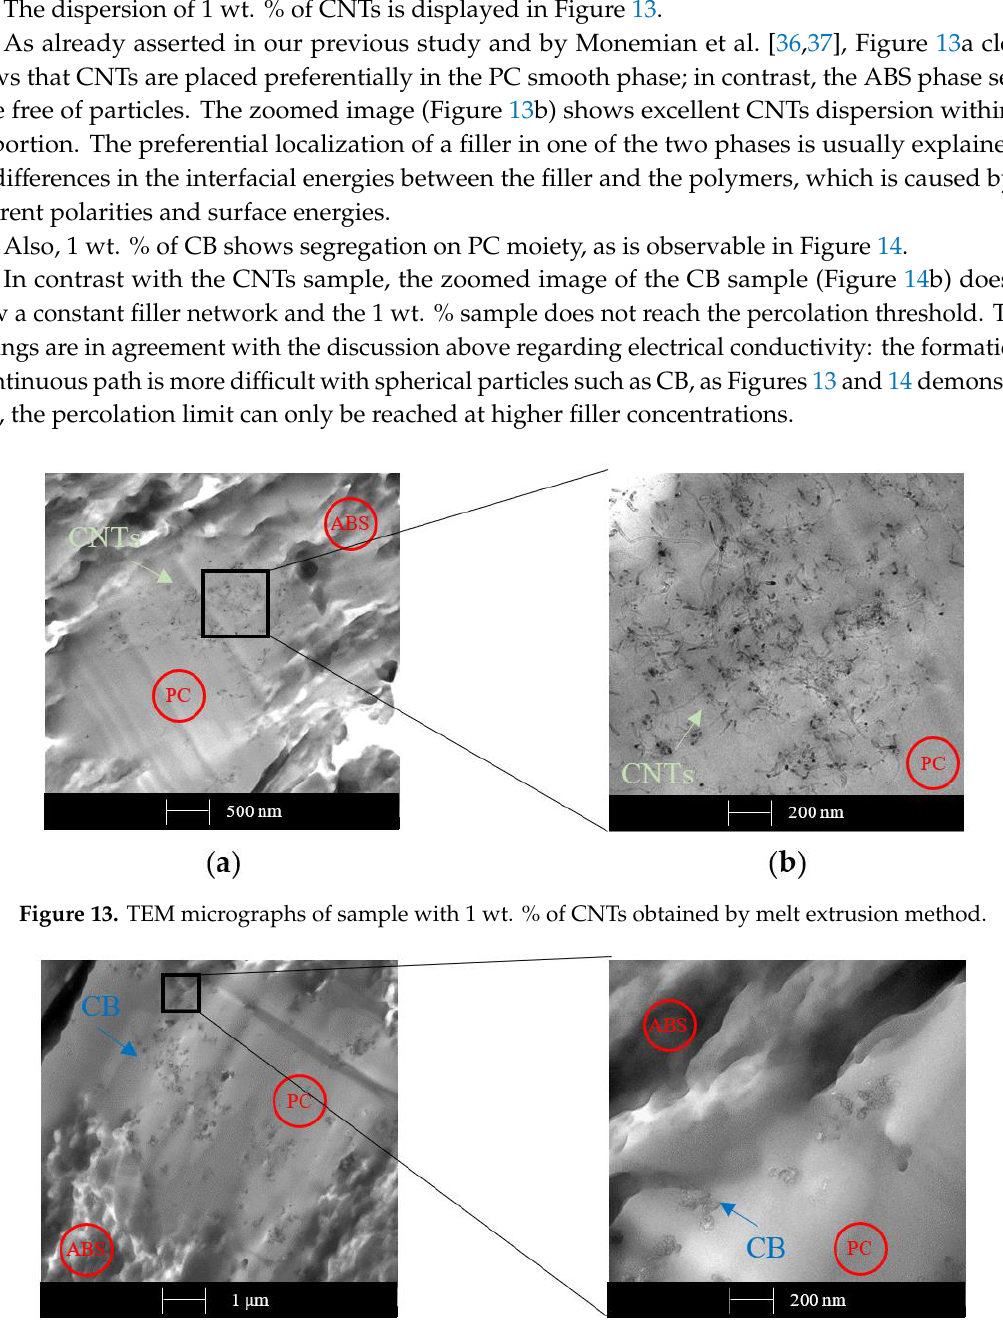
Figure 12. TEM micrographs of samples with 1 wt. % of GR obtained by solution dispersion methods: ( a ) with solvent removal by evaporation; ( b ) with solvent removal by precipitation.